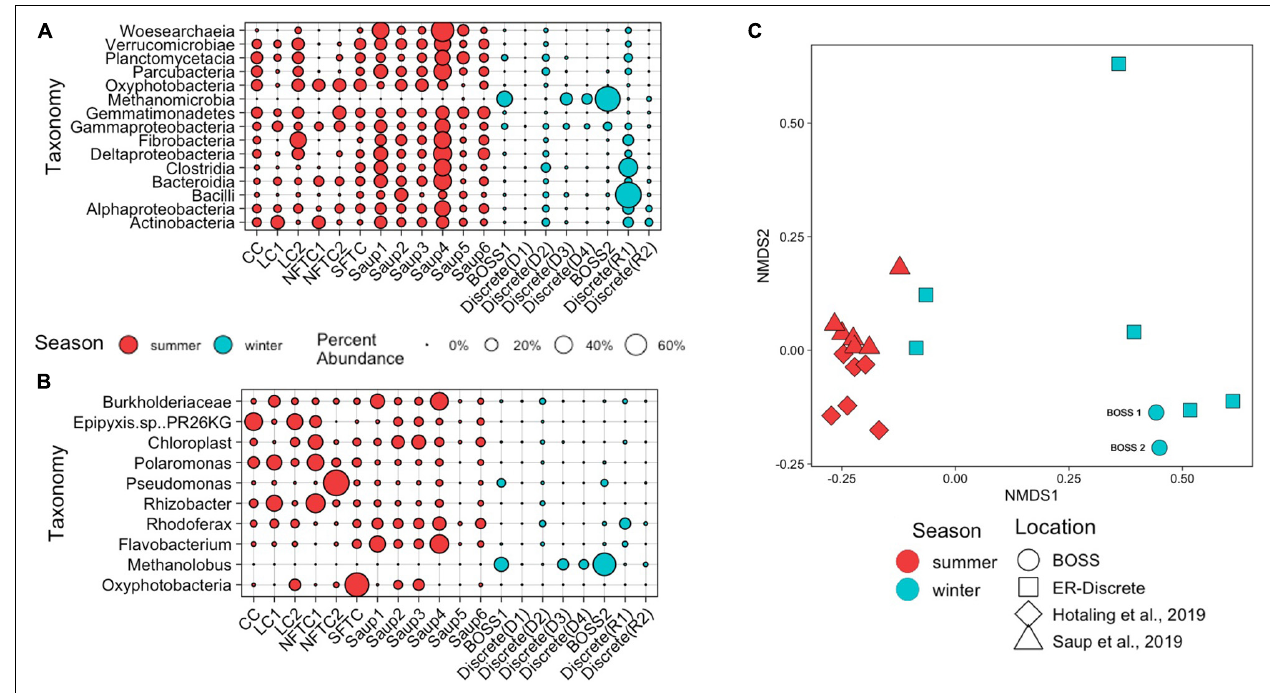
FIGURE 4 | Relative abundance of 15 most abundant Bacterial and Archaeal Classes (A) and top ASV from each class (B) from BOSS deployed in the ER along with other samples for comparison. Size of the circle represents relative abundance. Clements Creek (CC) and Lunch Creek (LC) are located in Glacier National Park (Hotaling et al., 2019), South Fork Teton Creek (SFTC) and North Fork Teton Creek (NFTC) are located in Grand Teton National Park (Hotaling et al., 2019). Saup1 and Saup2 are located at the sediment water interface (SWI) of Meander-A in ER, Saup3, and Saup4 are from the SWI of Meander-B in ER, and Saup5 and Saup6 are from the SWI of Meander-C in ER (Saup et al., 2019). Discrete sample replicates from this study taken during deployment (D) and retrieval (R) of the BOSS. (C) Non-metric multidimensional scaling (NMDS; NMDS stress = 0.081) based on Bray-Curtis dissimilarities between 16S rRNA gene sequences from BOSS (Hotaling et al., 2019; Saup et al.,